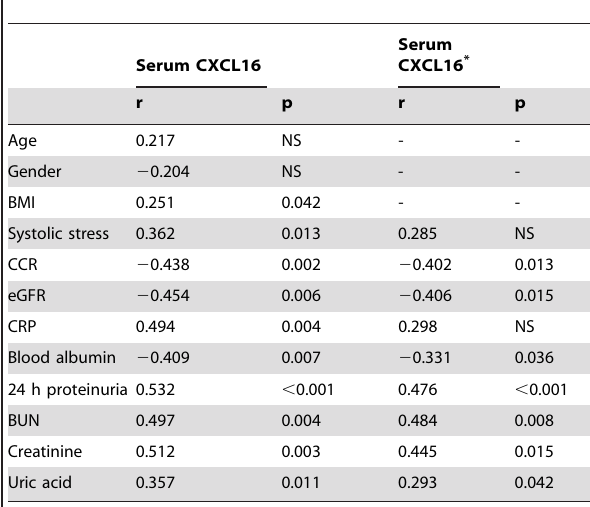
Table 2 Correlation of serum CXCL16 levels with anthropometric parameters, biochemical indexes and other relevant factors in subjects with DN